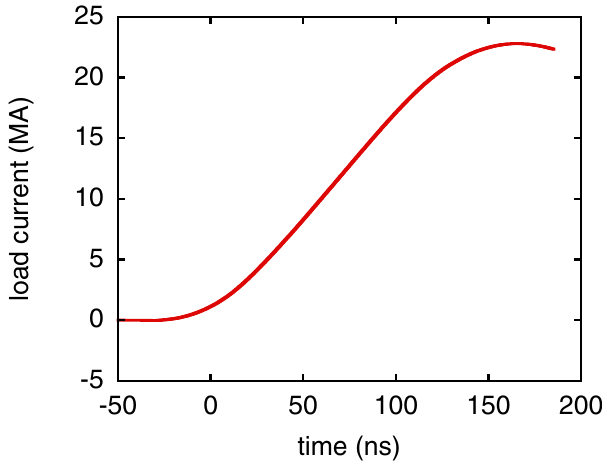
FIG. 9. (Color) Measured load current on Z-shot 532. The cur- rent time history deviates significantly from an ideal linear ramp for times greater than 130 ns. The plot ends at time t ¼ 185 ns , 20 ns after peak current.